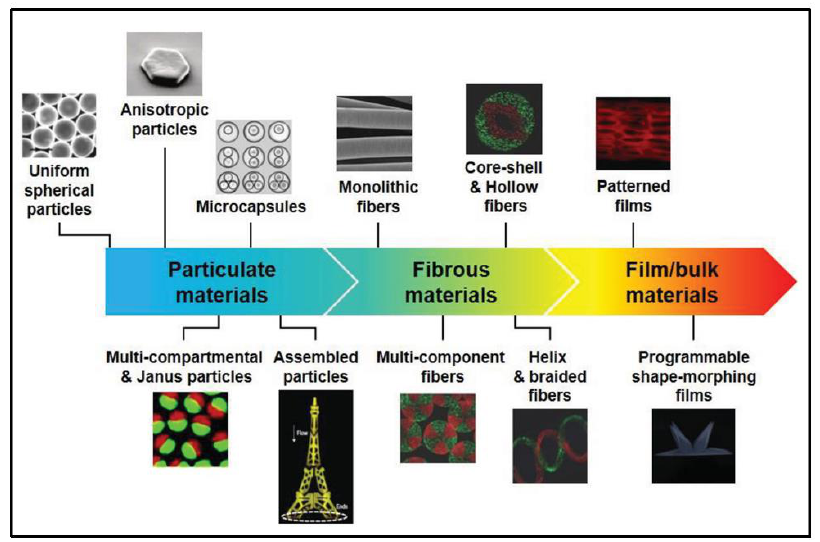
Figure 6. Synthesized microfluidic-based 0D/1D/2D/3D micro and nano materials. Reproduced with permission [60]. Copyright 2020, John Wiley & Sons.